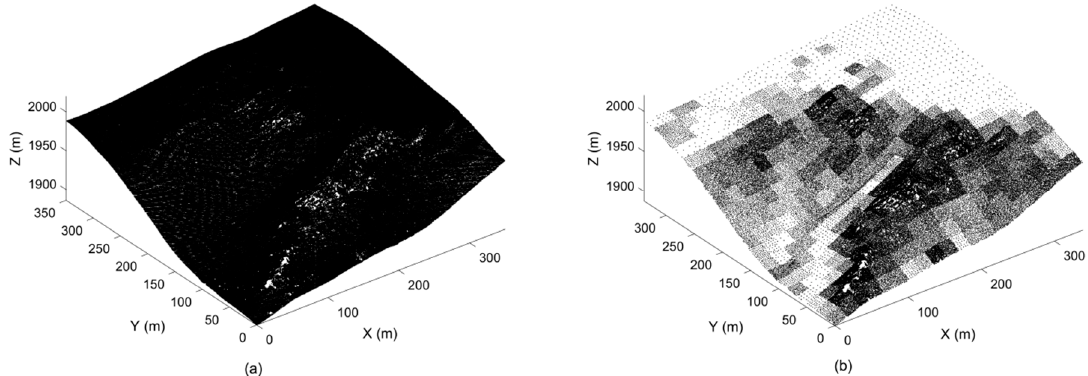
Figure 3. The hilly rough terrain surface: ( a ) the original point cloud, ( b ) the sub-sampled point cloud obtained using the coarse-to-fine method (20 × 20 = 400 sub-areas, the threshold root mean square error (RMSE) = 0.085 m).